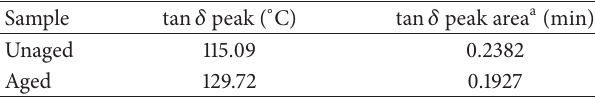
Figure 4: Change in toughness value of EHG250-68-37 composite specimens subjected to 800 h oxidative aging at 82 ∘ C. Table 1: Changes of tan 𝛿 curve of EHG250-68-37 composite samples induced by 800 h thermooxidative